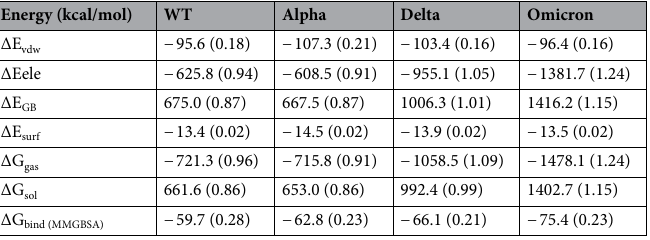
Table 1. Binding free energy for WT systems (SARS-CoV-2) and variants